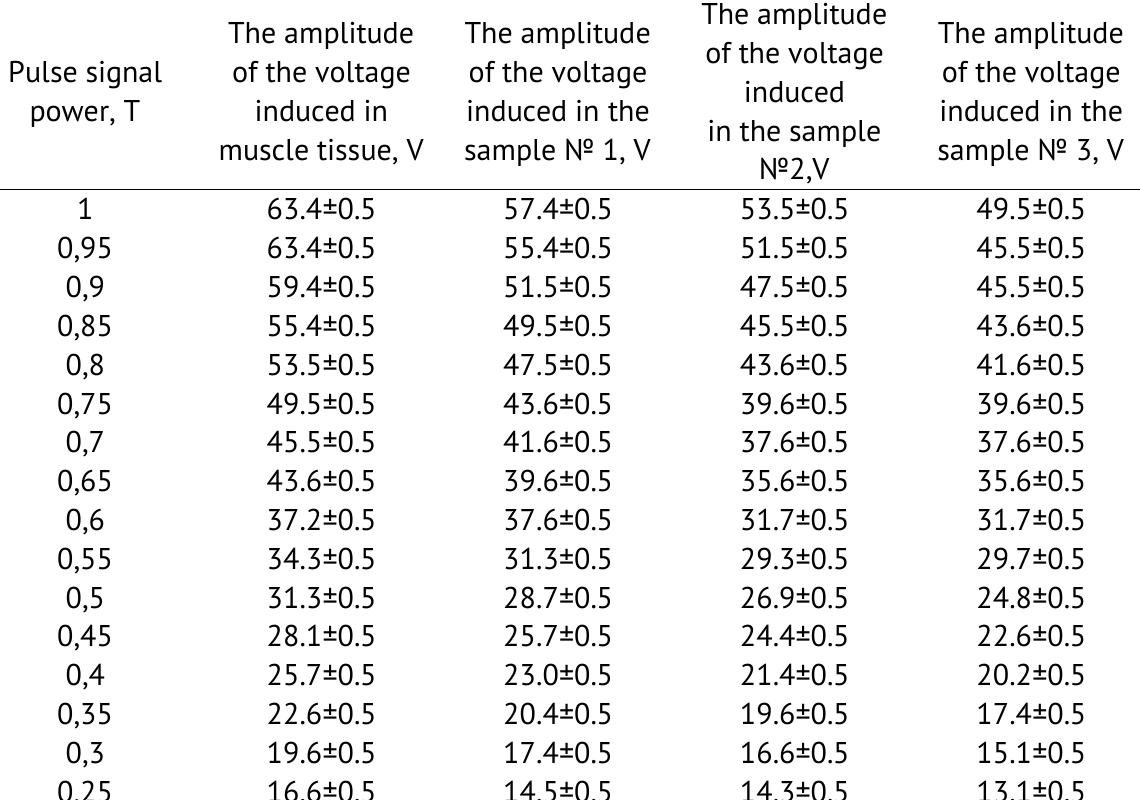
Figure 3. The shape of the signal induced by a pulsed magnetic field. The value of the induced signal amplitude in muscular tissue and in the developed samples of